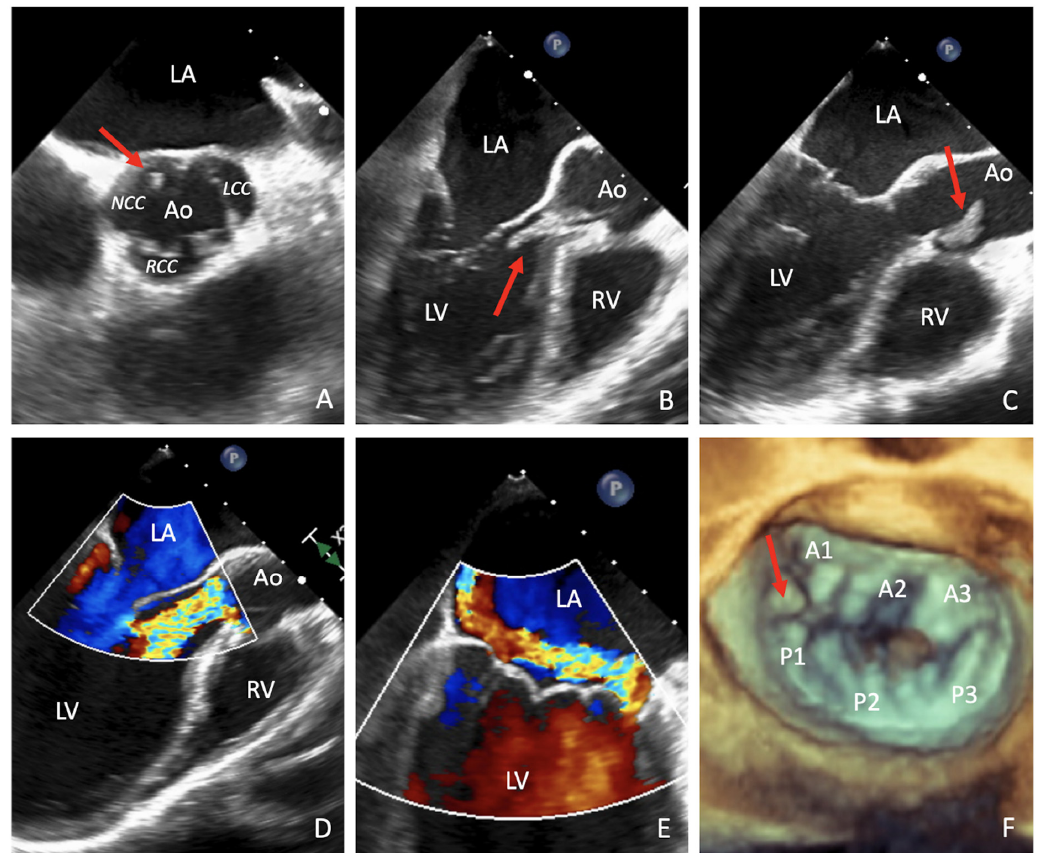
Figure 1. Pre-operative trans-oesophageal echocardiography (TOE). Four-chambers TOE showing a motile vegetation (red arrow) on the non-coronary cusp of the aortic valve ( A ) during diastole ( B ) and systole ( C ), resulting in severe aortic regurgitation (AR) ( D ); Color doppler ( E ) and four-dimensional (4D) TOE ( F ) reported a concomitant severe MR due to P1 flail.